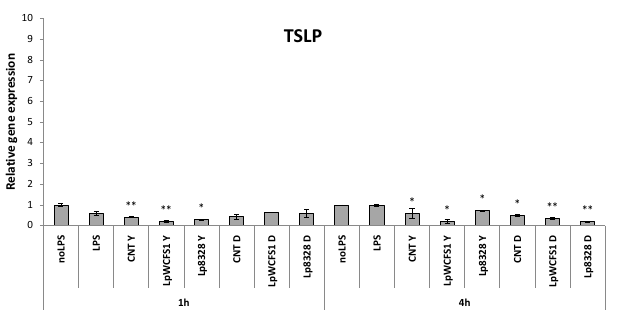
Figure 4. Relative expression of cytokine-related genes after the exposure to undigested (Y) and in vitro digested (D) samples containing Lactobacilli strains over 1 h and 4 h of treatments. Values represent the mean ± the standard deviation of two different experiments. Statistical analyses were carried out by the Student’s t -test, and significant differences are relative to LPS-stimulated THP-1 cells without strains (LPS, positive control) (* p < 0.05 and ** p < 0.005). noLPS, no LPS-stimulate THP-1 cells used as negative control; CNT, yogurt inoculated with S. thermophilus and L. bulgaricus subsp. delbrueckii was the matrix control; LpWCFS1, yogurt inoculated with S. thermophilus , L. bulgaricus subsp. delbrueckii and L. plantarum WCFS1; Lp8328, yogurt inoculated with S. thermophilus , L. bulgaricus subsp. delbrueckii and L. plantarum CECT